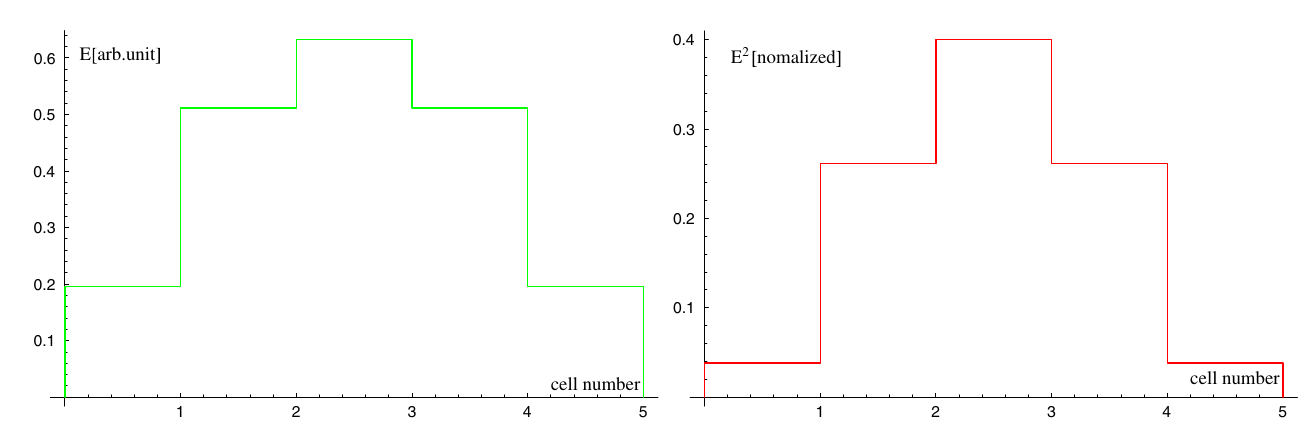
FIG. 12. (Color) Five-cell cavity; left: field profile, right: field-square profile (normalized).